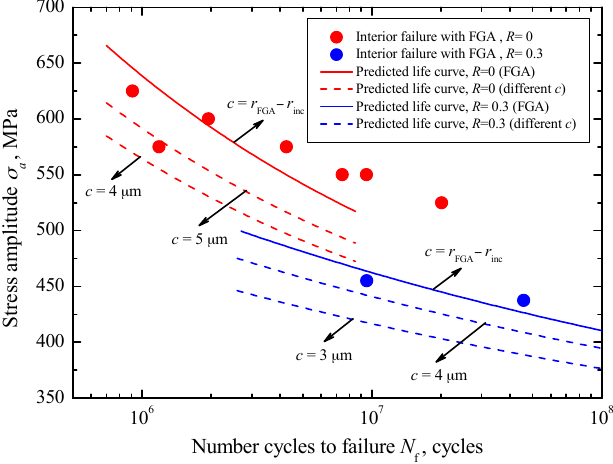
Figure 12. Predicted crack initiation lives at different c -values under R = − 1. Materials 2017 , 10 , 1084